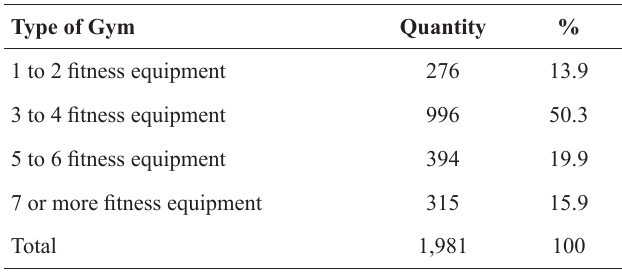
Figure 6: Percentage of all households of different socioeconom- ics groups with an outdoor gym at a distance up to 500 m. Source: own elaboration.